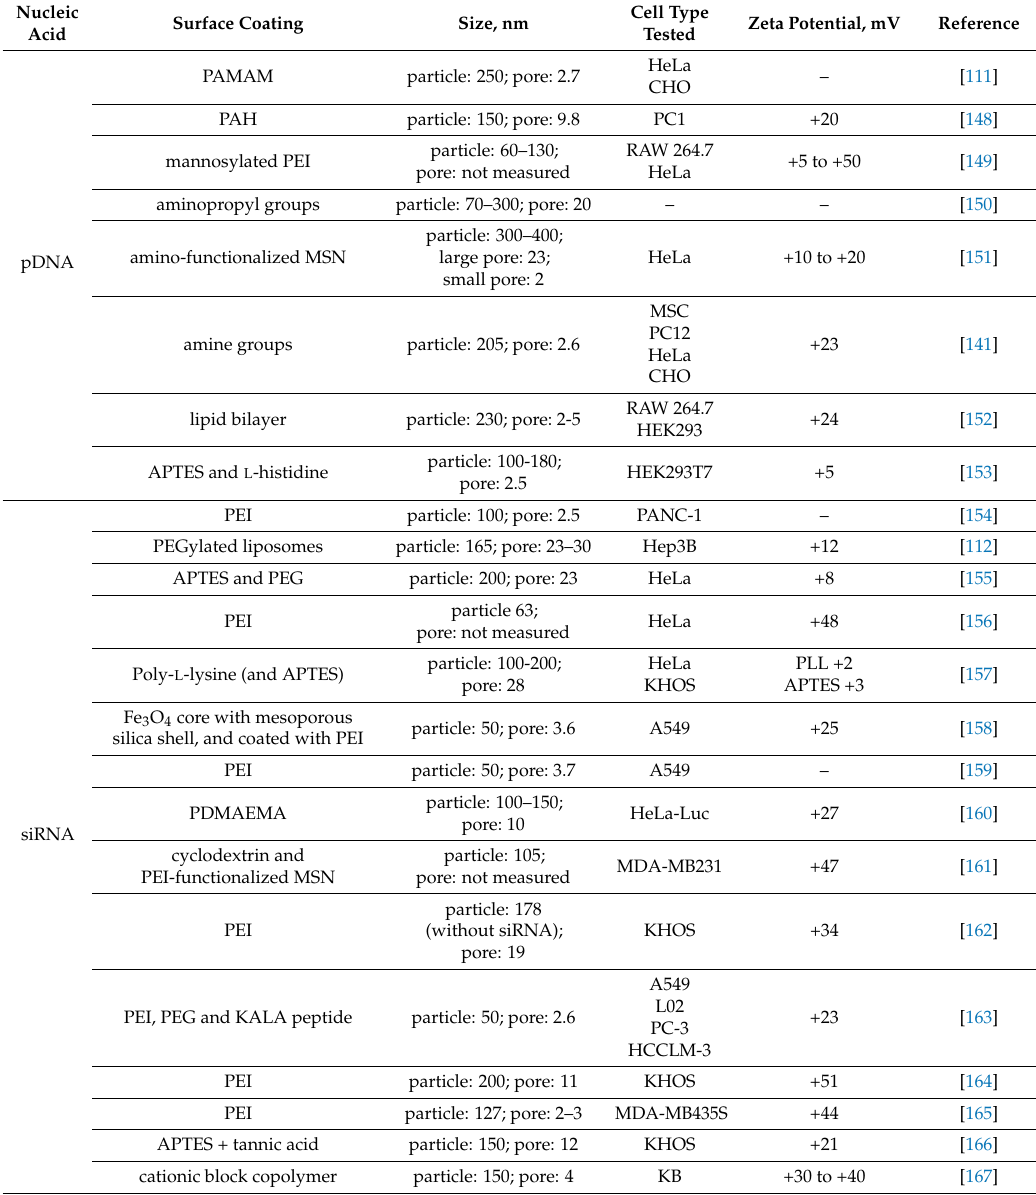
Table 2. Particle and pore sizes and surface coatings in nucleic acid delivery systems with mesoporous silica nanoparticles